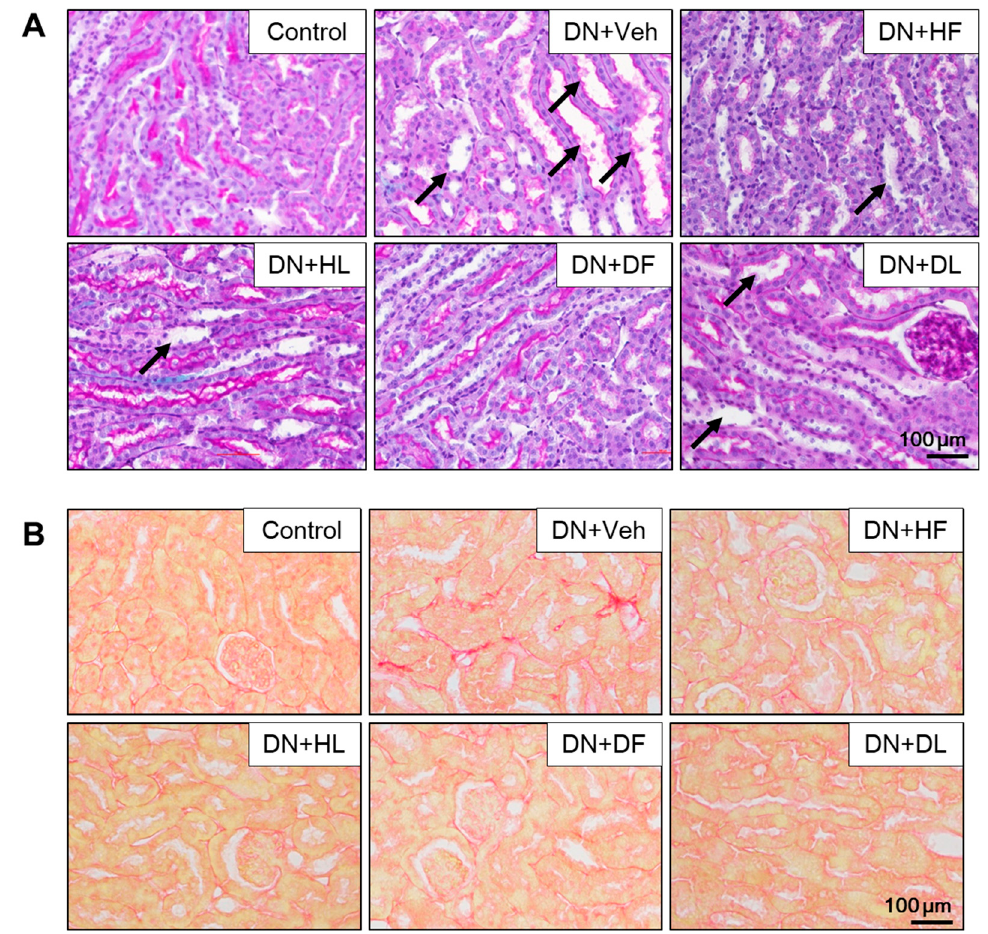
Figure 3. AM extract treatment reduced tubular damage and collagen accumulation in DN mice. Kidney tissues were processed for PAS ( A ) and Sirus red staining ( B ). Representative images are shown. Arrows indicate damaged tubules. Scale bar, 100 μ m.